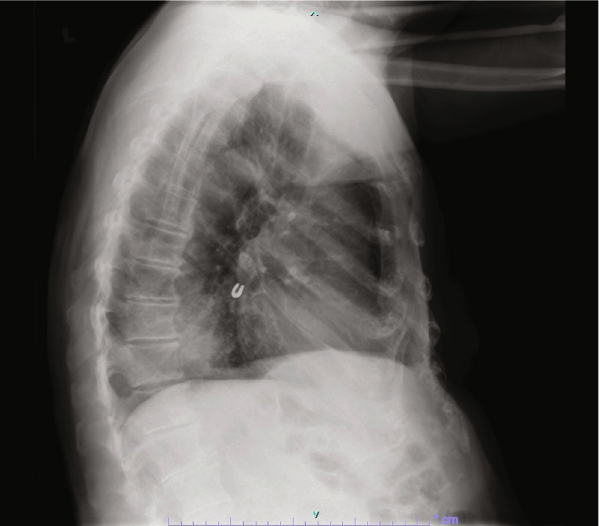
Figure 2: Lateral chest X-ray demonstrating radiopaque foreign body.